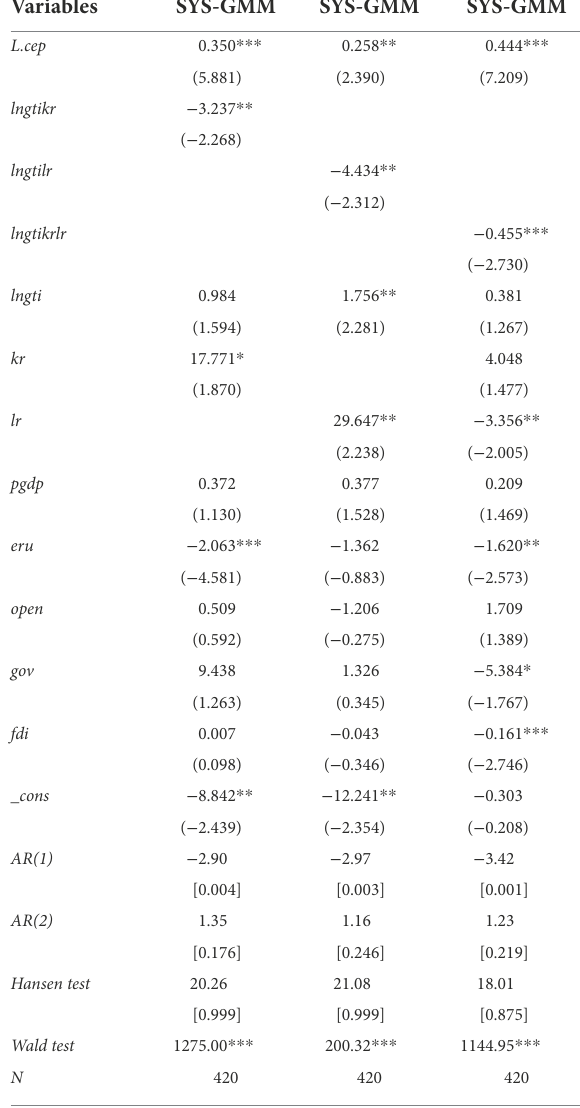
TABLE 4 The regression results of moderating